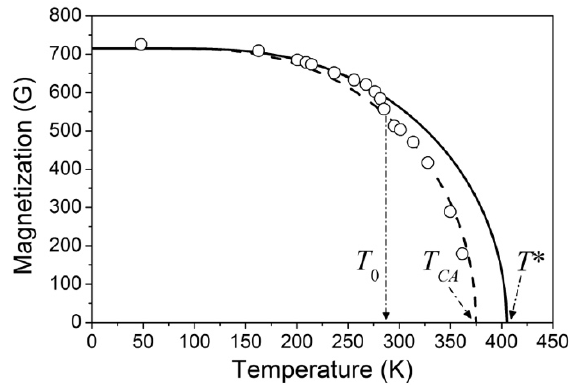
Figure 1. Saturation magnetization of Alloy A computed from Equation (5) (lines) and measured in Reference [21] (open circles). The dashed and solid lines are fitted to the magnetization values measured for the austenitic and martensitic phases, respectively. The fitting was performed by the proper choice of T CA value and parameter κ in the formula for T *. The dependence shown by the solid line is used for computation of the magnetic entropy change.